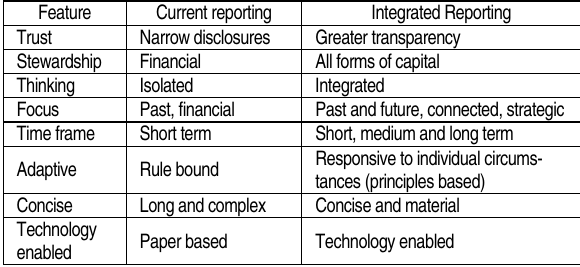
Table 2. Current reporting Vs Integrated